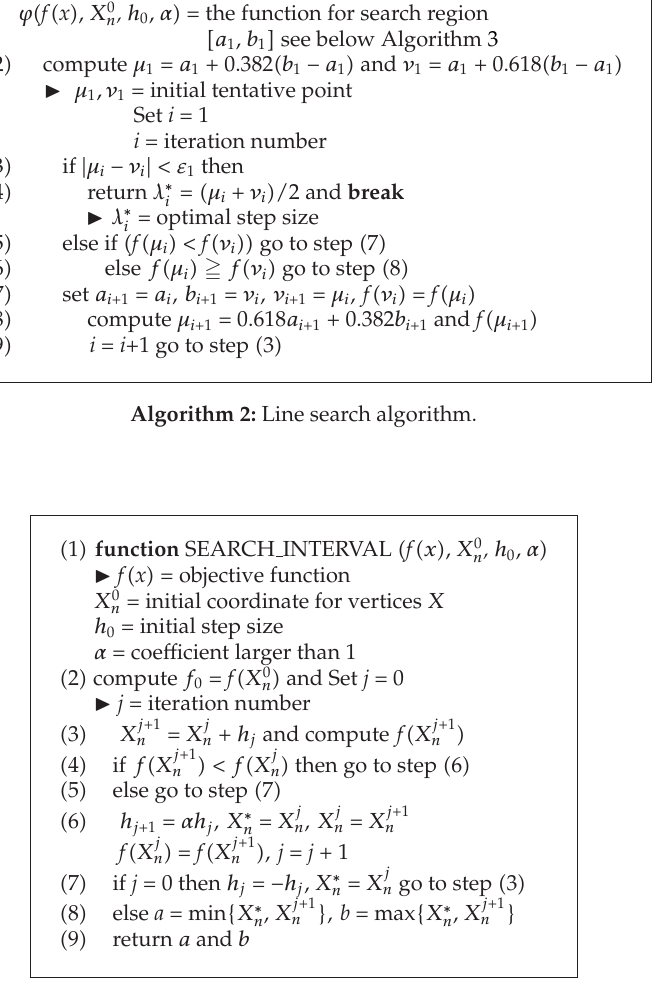
Algorithm 3: Interval search